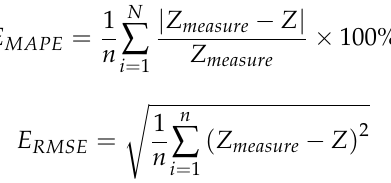
Table 2. The results of MAPE and RMSE of the three methods. Parameter Black Box